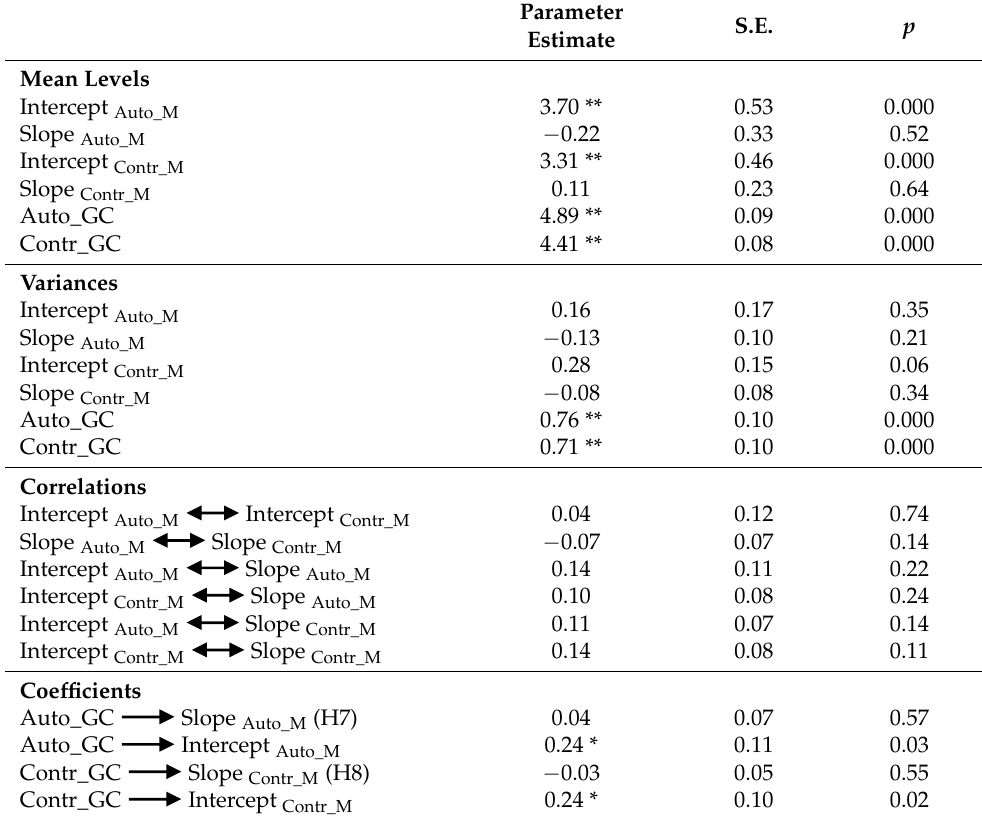
Table 7. Parameter Estimates for LGM Models: GCO and Motivation.